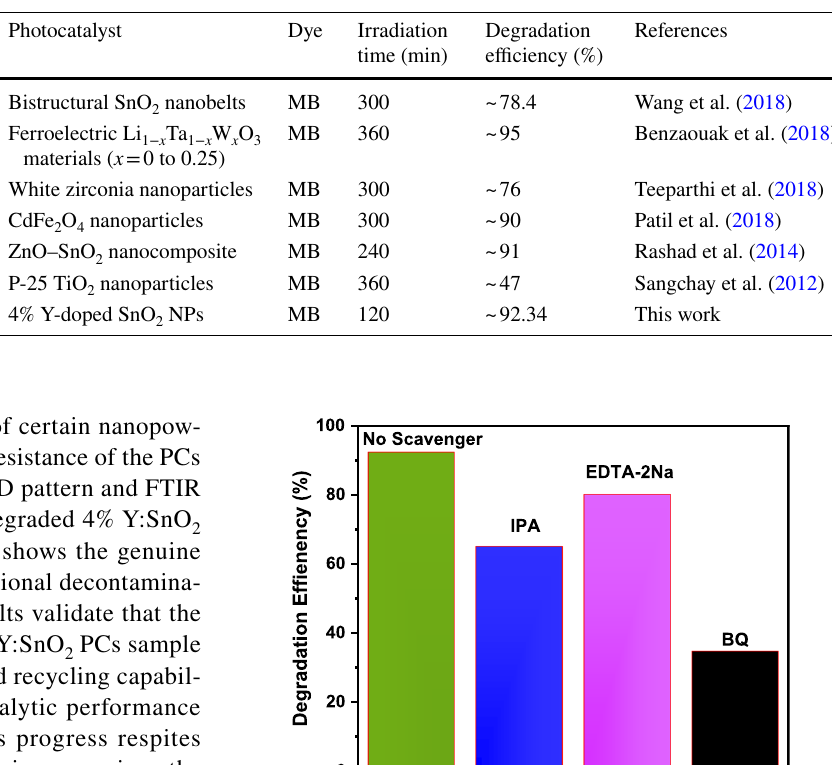
2 NPs fresh and used photocatalytic reaction